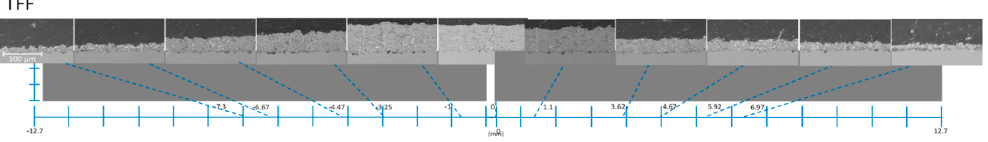
Figure 16. Cross-section images showing the columns in the cylindrical sample with fine grit blasting (TFC).